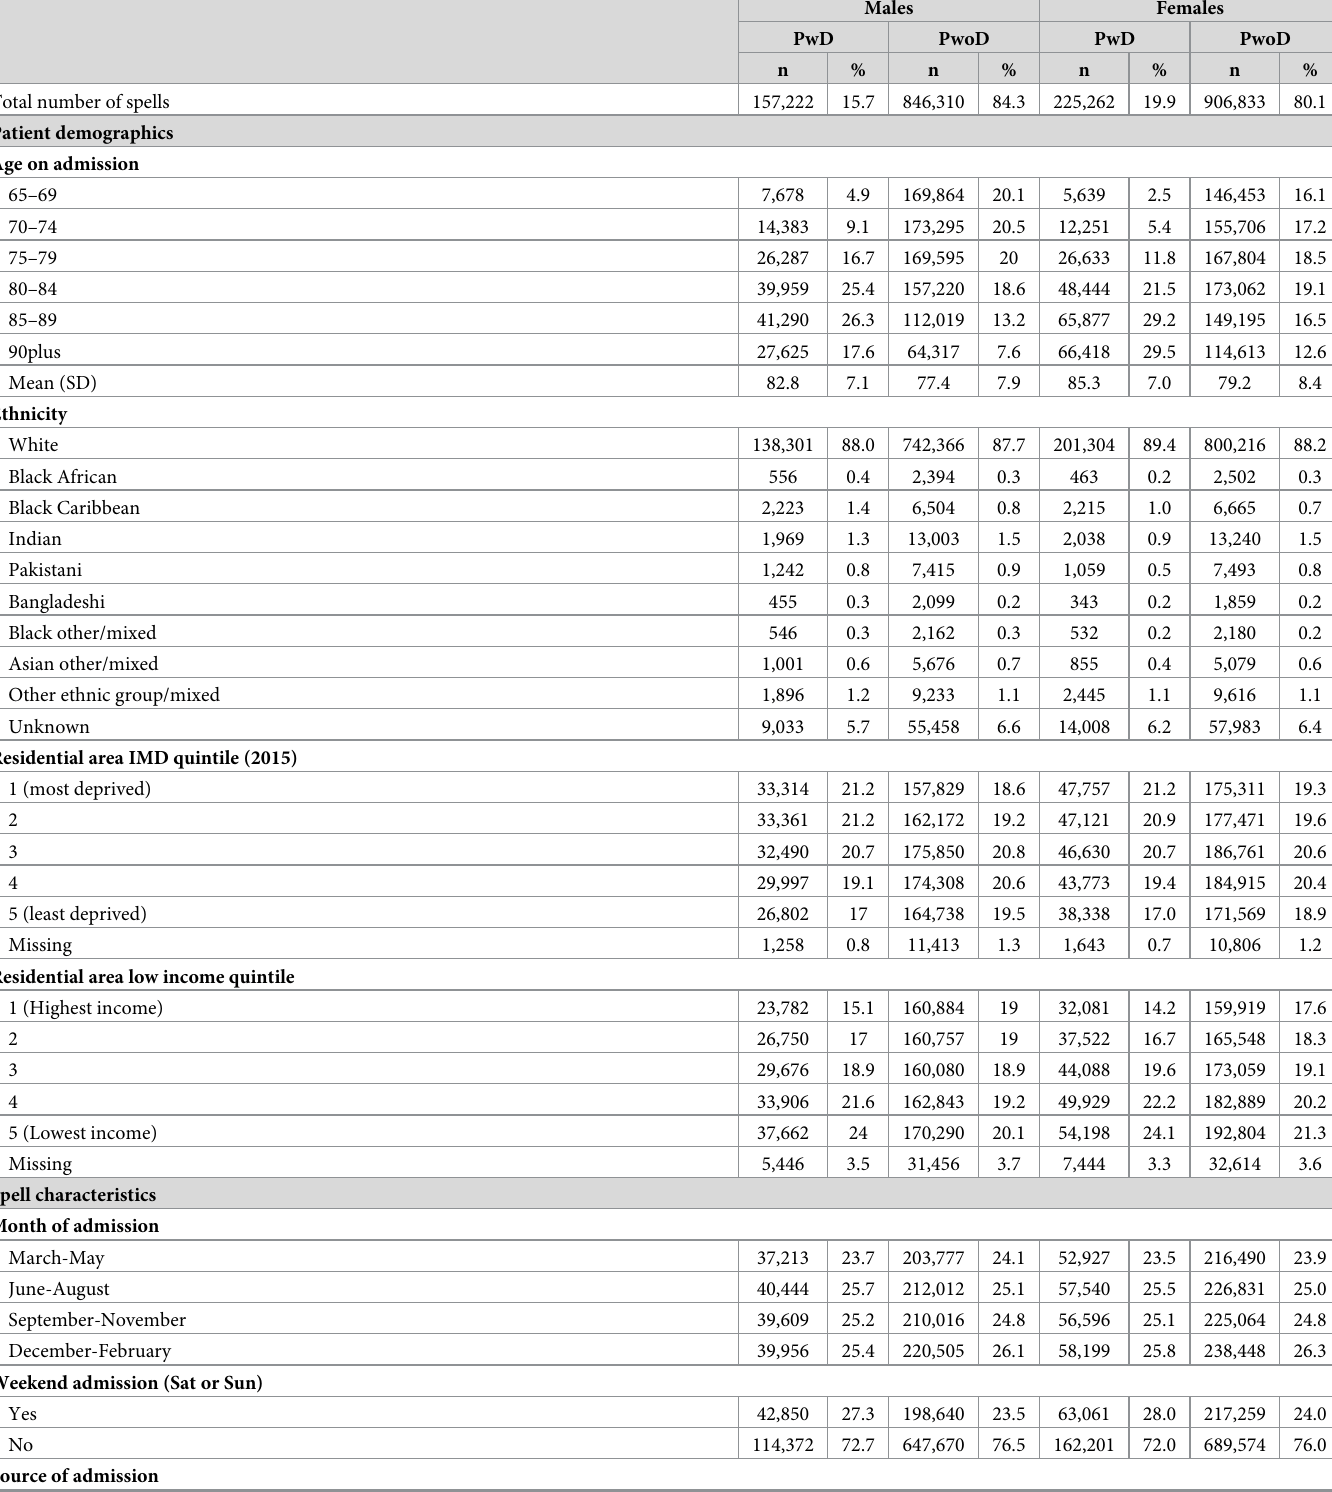
Table 2. Descriptive statistics for the FY2016/17 hospital spell